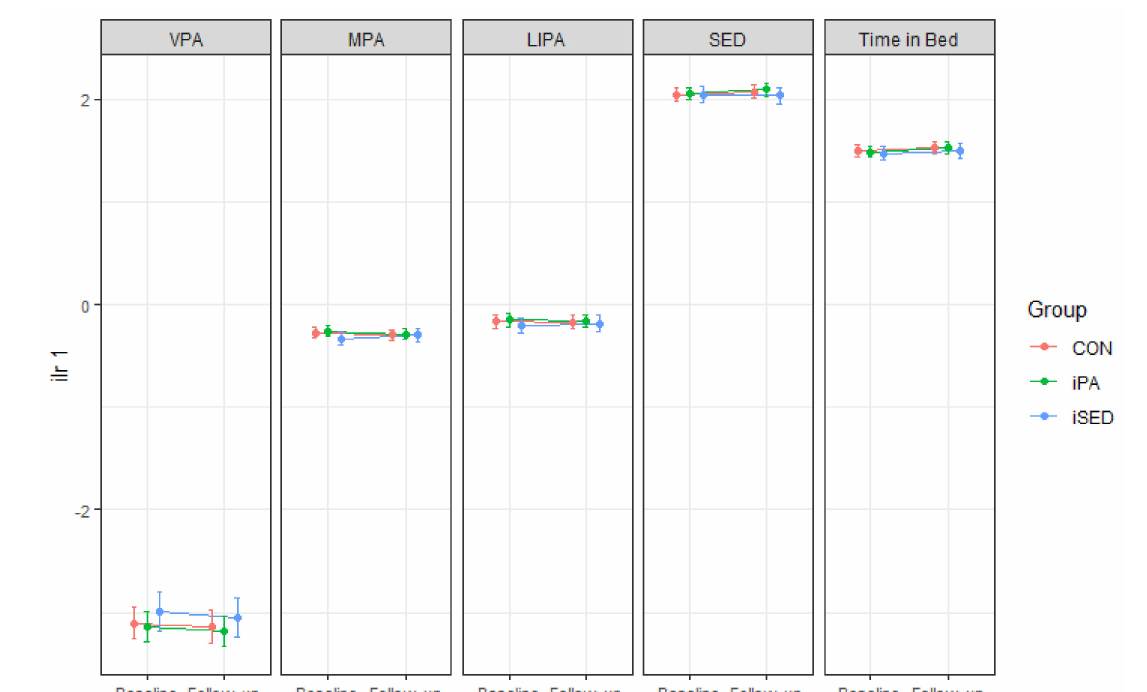
Figure 3. Marginal means (with 95% CI) for each movement behavior, expressed in terms of ilr 1 (time spent in that behavior relative to time spent in all other behaviors) at baseline and 6-month follow-up. Values were estimated based on the results in the linear mixed models. VPA: vigorous-intensity physical activity, MPA: moderate-intensity physical activity, LIPA: light-intensity physical activity, SED: sedentary behavior. iPA: Intervention group focused on increasing physical activity, iSED: Intervention group focused on reducing sedentary behavior, CON: Control group.